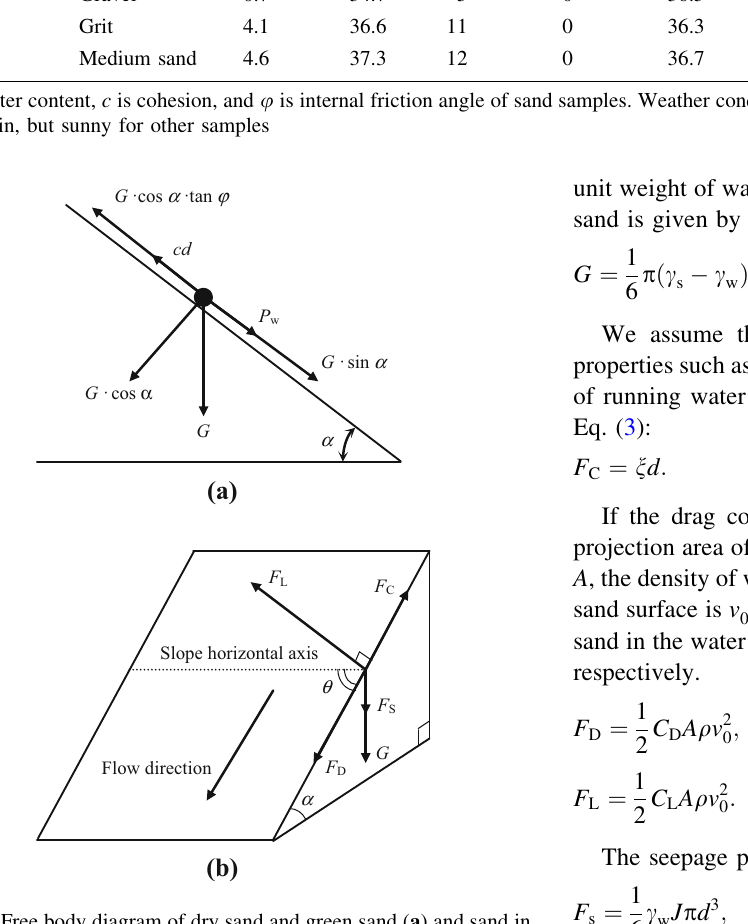
Fig. 2 Free body diagram of dry sand and green sand ( a ) and sand in a water–sand flow ( b